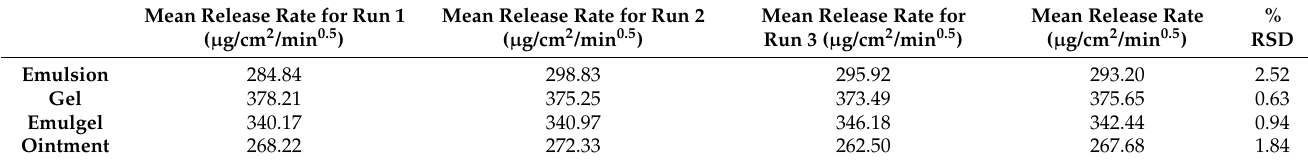
( µ g/cm 2 /min 0.5 ) and % RSD for six